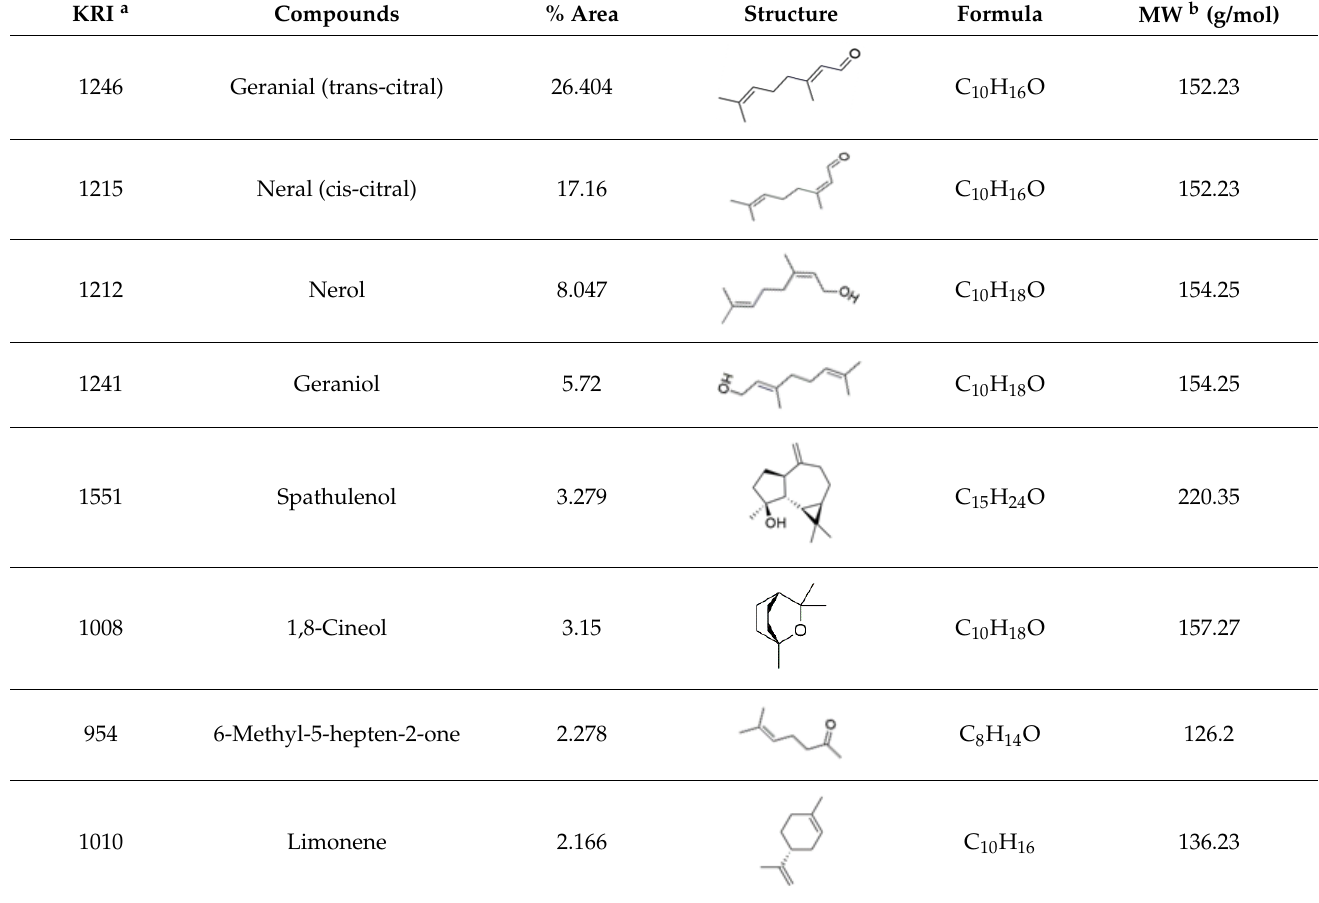
Table 1. The 10 most abundant volatile compounds identified in Lippia citriodora essential oil (LCO) by GC-MS analysis. Data reproduced from Fitsiou et al. [27].